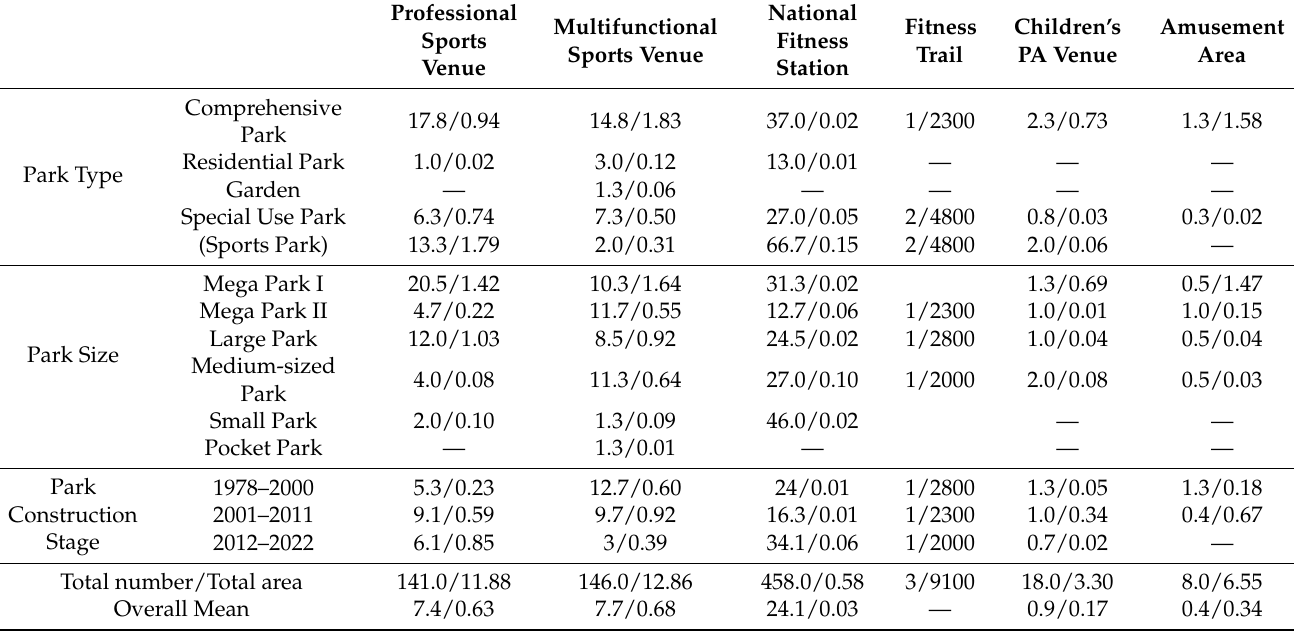
Table 2. Park-based fitness facilities in